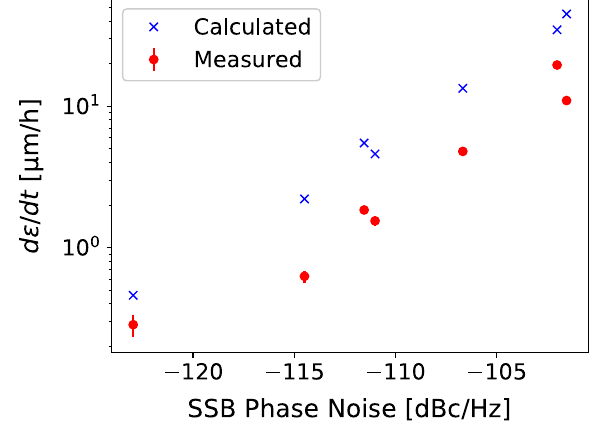
FIG. 5. Emittance growth measurements as a function of single sideband (SSB) phase noise injected into the cavity feedback on a logarithm